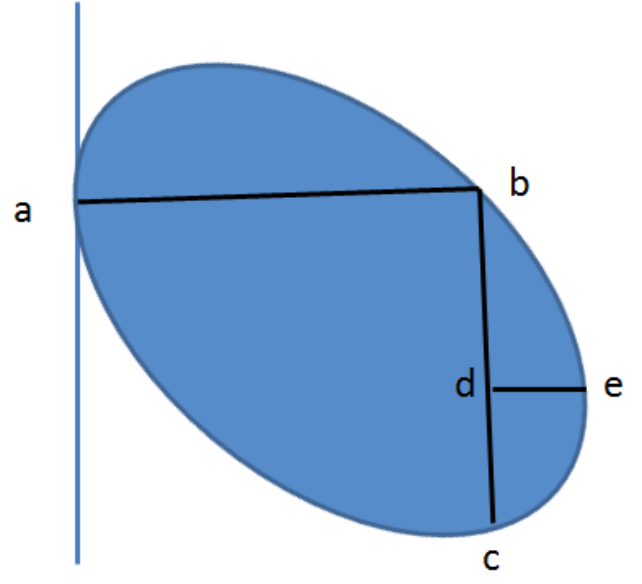
Figure 9. Identification of polyester short fibers by the center point method.